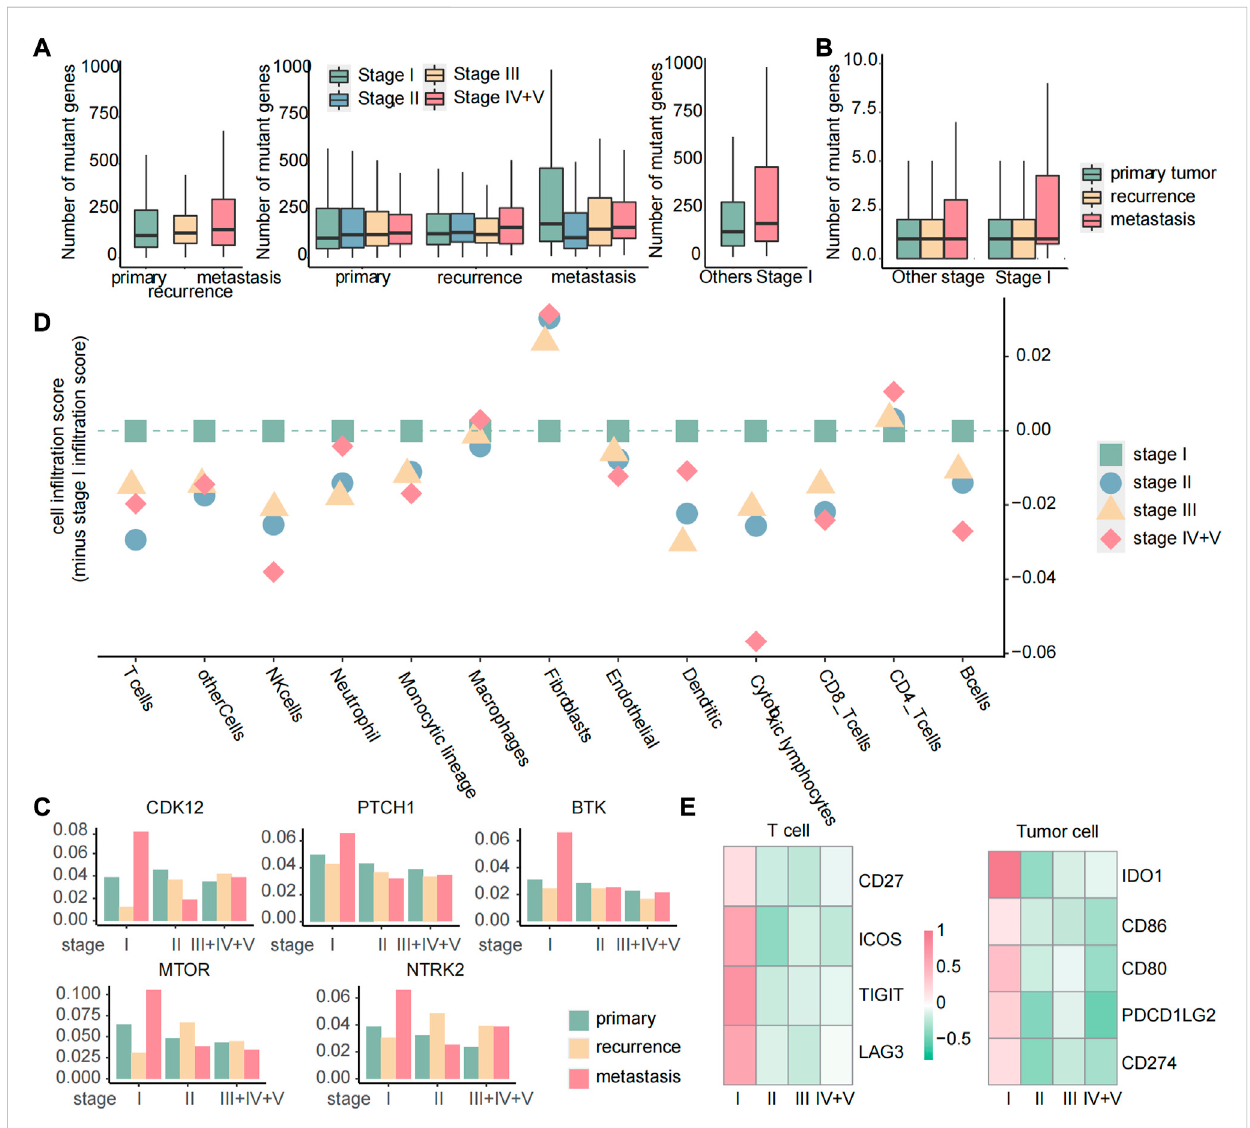
Targeted therapy and immune checkpoint therapy are more effective for early metastases. (A) Boxplot of the number of mutated genes in primary, recurrent, and metastatic tumors, boxplot of the number of mutated genes in primary, recurrent, and metastatic tumors of each stage, boxplot of the number of mutated genes in metastatic tumors of stage I and other stages. (B) For 158 genes related to targeted therapy, boxplot of the number of mutated genes in each sample. (C) Histogram of the mutation rate of speci fi c targeted therapy-sensitive genes. The samples were divided into primary,recurrent,andmetastaticsamplesatdifferentstages. (D) Dotplotofthescoreofimmunecellin fi ltrationinmetastatictumors.Allthescoreswere reducedbythecellin fi ltrationfractionofstageI.Ifthescoresofotherstageswerelessthan0,weconsideredthatthecellhadthehighestin fi